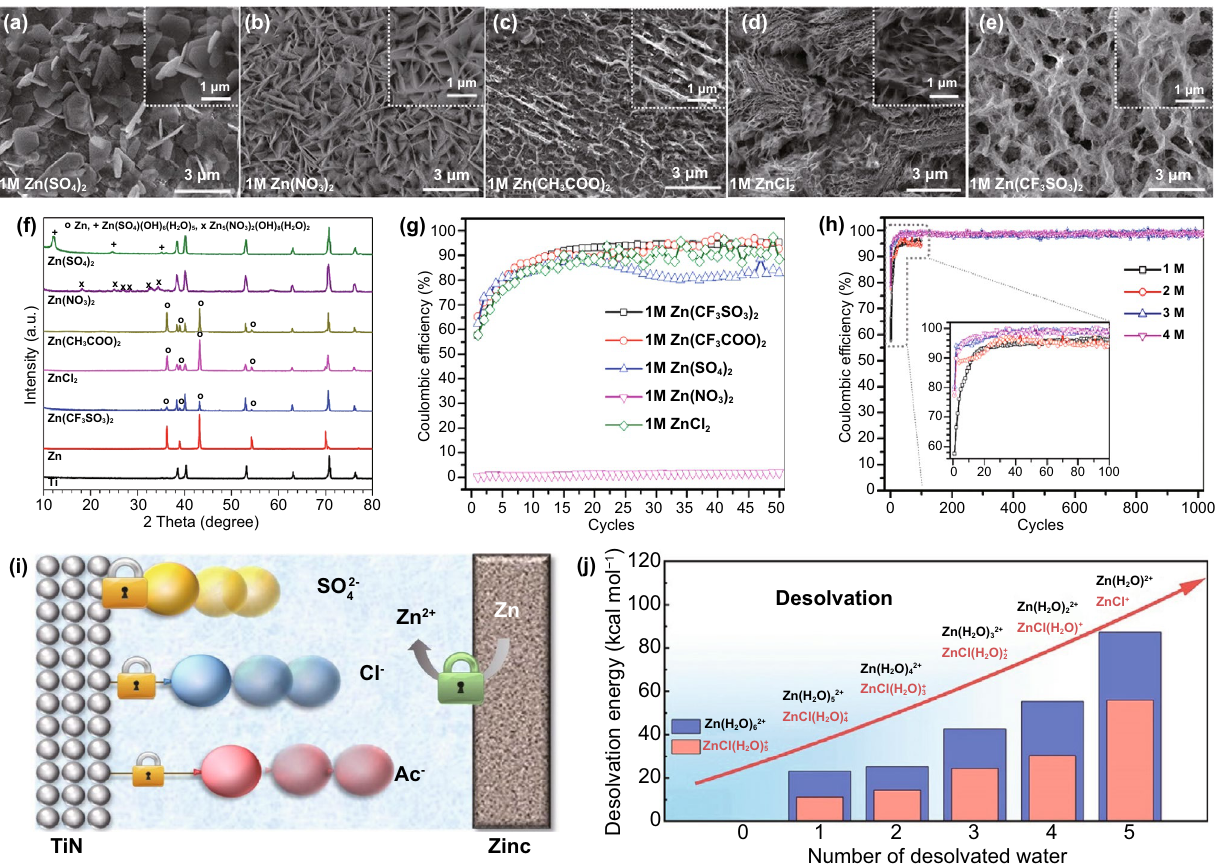
Fig. 10 a–e SEM images of pristine Zn and Ti foils with Zn layer plated in various electrolytes. f Corresponding XRD patterns and g coulombic efficiencies (CEs) of Zn depositing/stripping in various electrolytes. h CEs in Zn(CF 3 SO 3 ) 2 electrolytes with different concentrations. Repro‑ duced with permission from Ref. [82]. Copyright 2019, Wiley–VCH. i Schematic illustration of self‑discharge behaviors of Zn//TiN ZHSCs in three different electrolytes. Reproduced with permission from Ref. [169]. Copyright 2021, Wiley–VCH. j Desolvation energies of [Zn(H 2 O) 6 ] 2+ and [ZnCl(H 2 O) 5 ] + . Reproduced with permission from Ref. [170]. Copyright 2021,